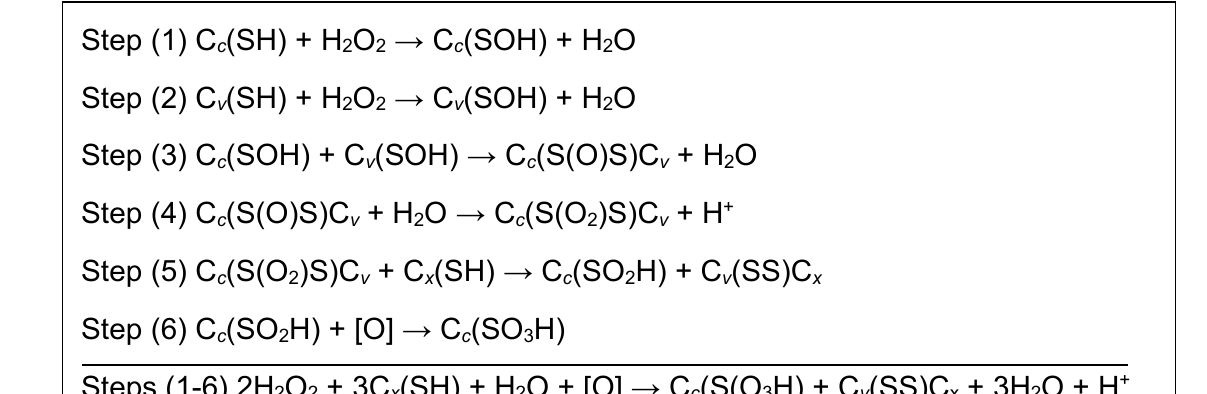
Scheme 3. The six individual oxidation steps and overall redox − balanced oxidation equation for the oxidation of h − GAPDH by H 2 O 2